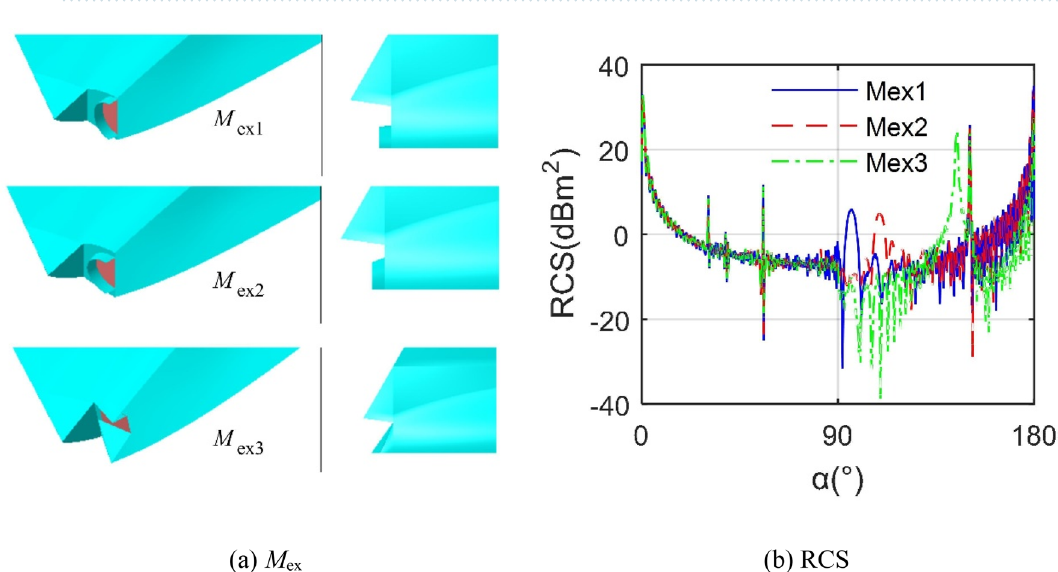
Figure 10. RCS of aircraft under different exhaust port models, f R = 10 GHz, β = 0°, drawn using Microsoft Visio 2007 and CATIA